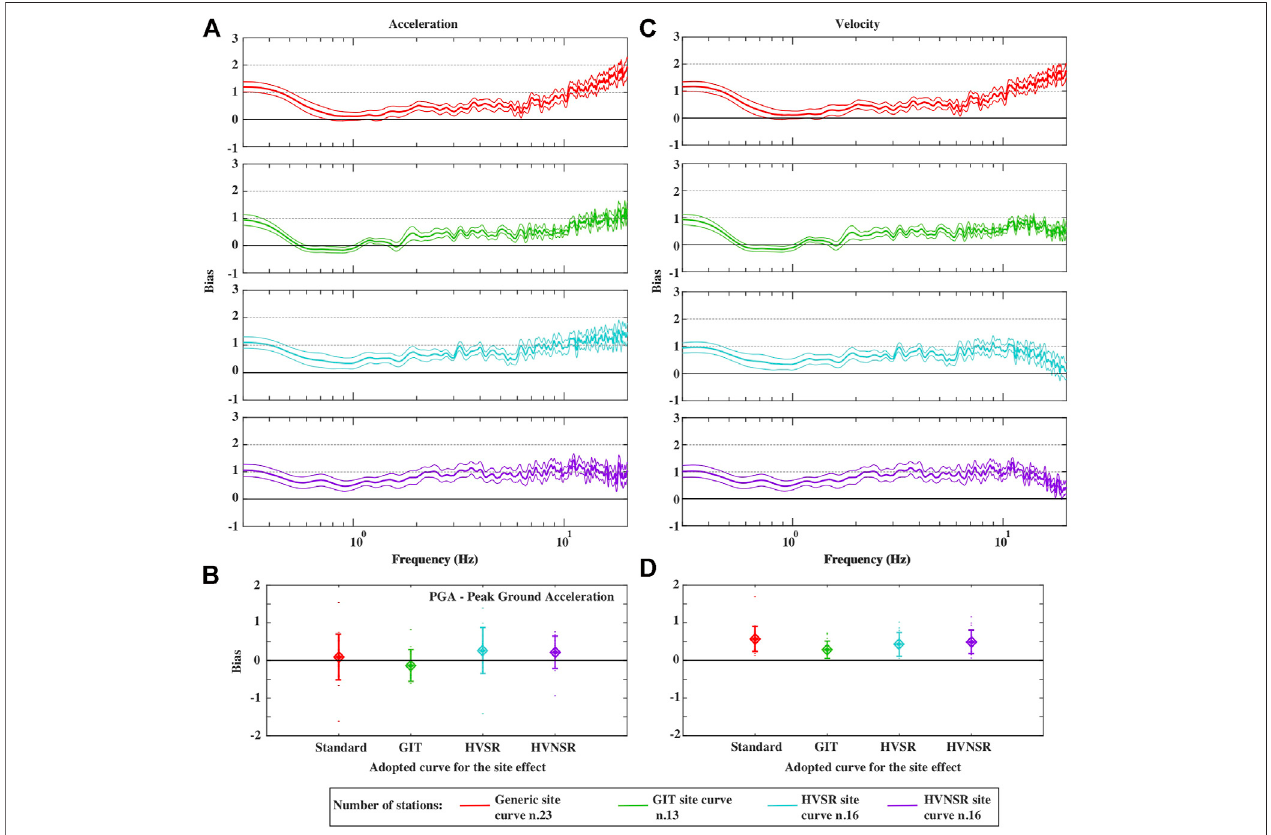
FIGURE5| Biascalculatedfollowing Eq.10 ,togetaninsightintotheperformanceofthegenericandempiricalsiteampli fi cationcurvesexploitedintheEXSIMcodeall overthestationsampleinsedimentarybasins.Thetoppanelsshowbiasversusfrequencyforbothacceleration (A) andvelocity (B) spectra.Blackcurvesrepresentthebias obtained by applying the generic site curve, while color curves are related to the use of GIT (green), HVSR (cyan), and HVNSR (violet) site curves. The standard deviation is plotted as well. The bottom panels show the bias calculated for peak ground acceleration [PGA, panel (B) ] and peak ground velocity [PGV, panel (C) ].